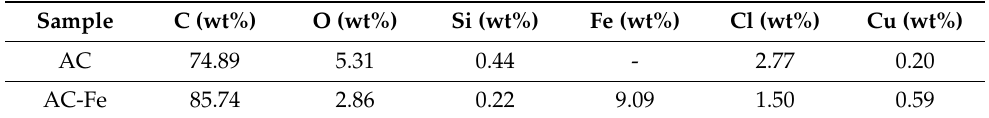
Table 2. EDS analysis of AC and AC-Fe.